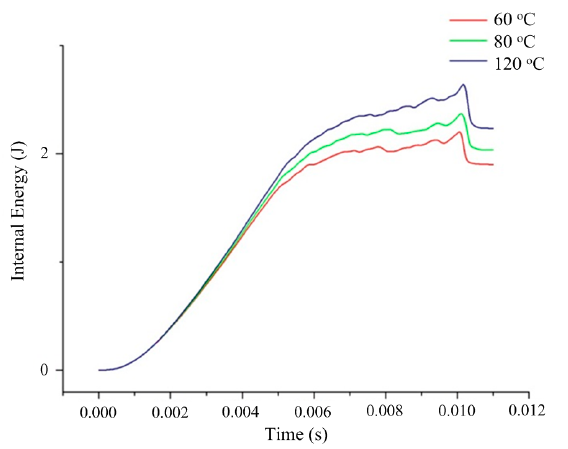
Figure 9. Internal energy variation of specimen with different mold temperatures during the impacting.